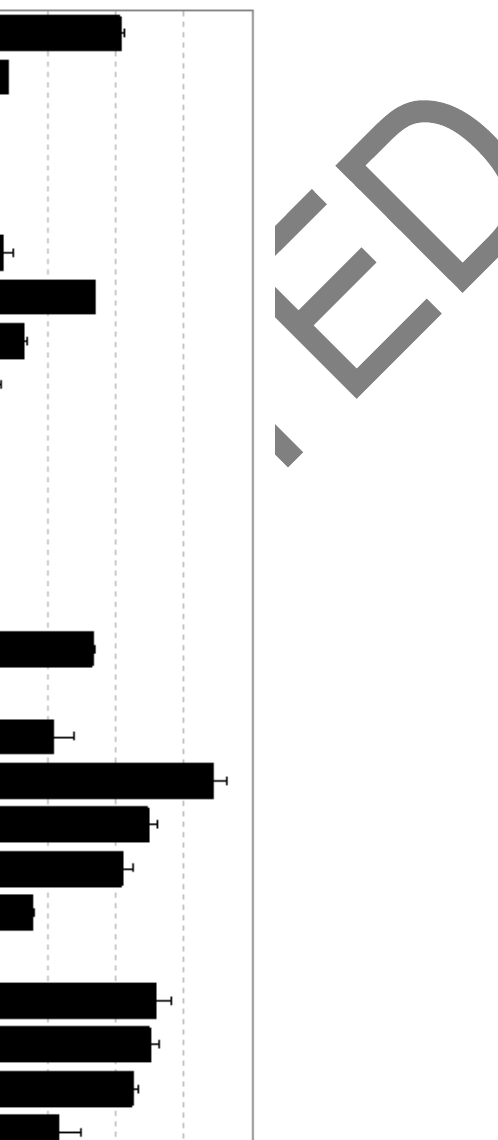
Figure 2. The inhibitory effect of the synthesized compounds (20 µg/mL) on the generation of NO (using nitrites index) from LPS-stimulated